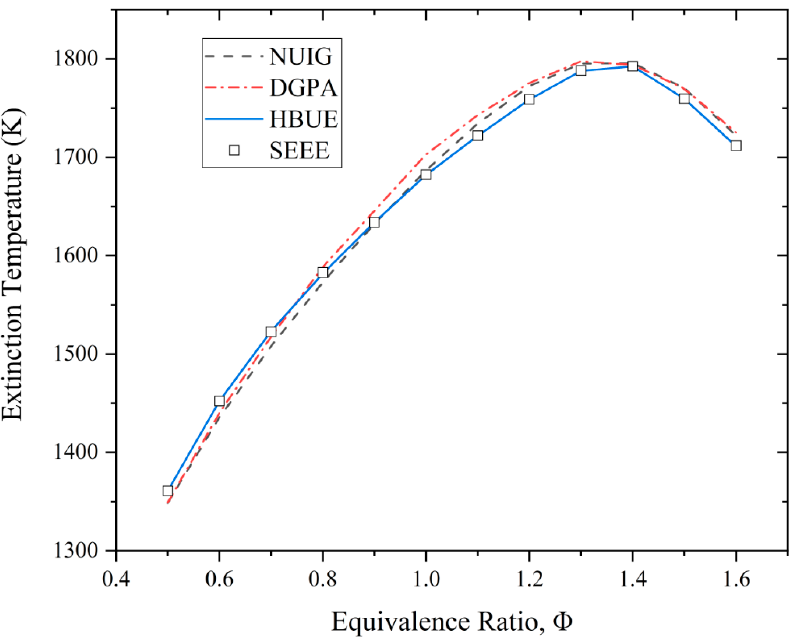
Figure 15. Comparison of the extinction temperatures between NUIG, DGPA, HBUE, and SEEE at equivalence ratios of 1.0 and an initial temperature of 298 K.